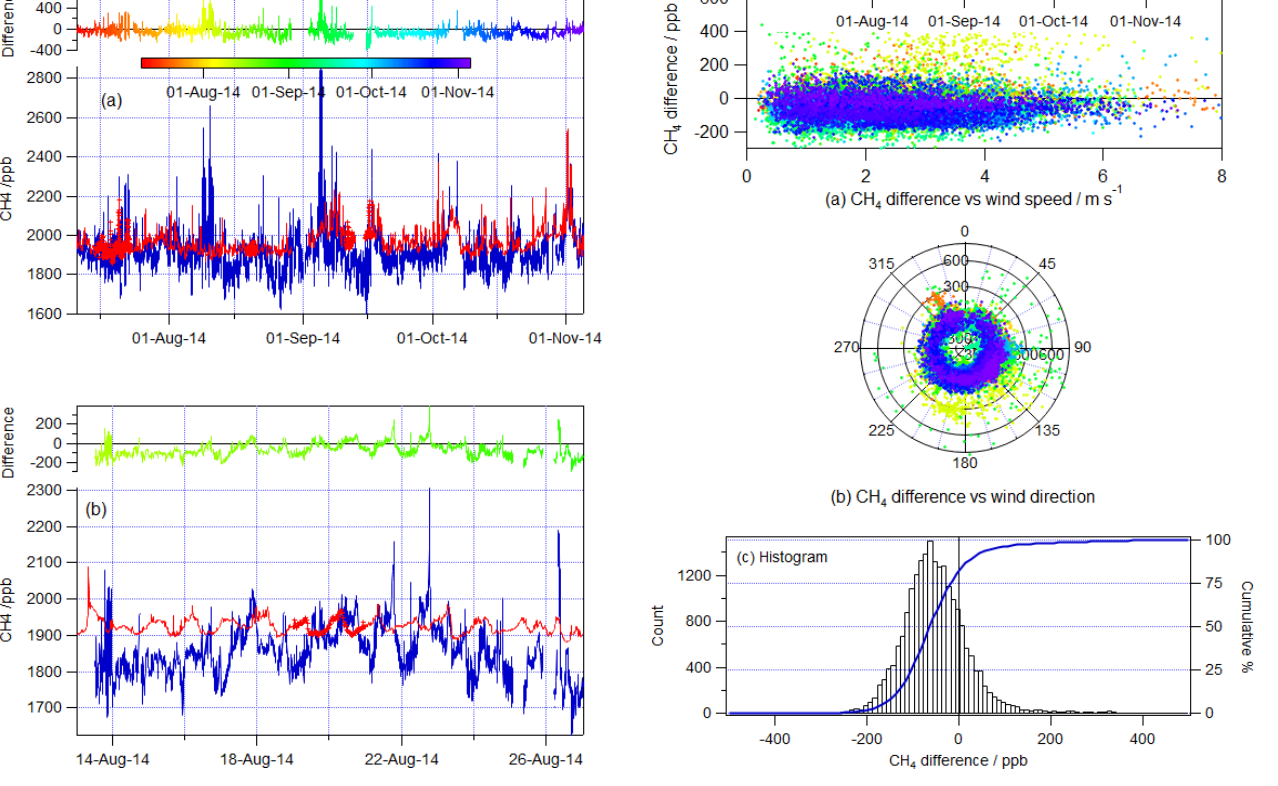
Figure 12. CH 4 mole fraction differences between open-path and in situ measurements (OP – in situ) (a) vs. wind speed, (b) as a wind speed rose and (c) as a histogram of the differences. (a, b) are coloured by time to compare with Fig.